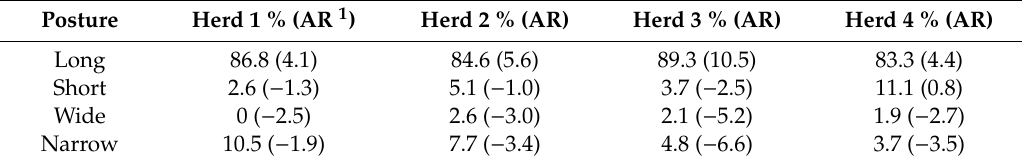
Figure 4. Percentage of “long”, “wide”, “short”, and “narrow” postures per herd, as recorded in 357 observations of 205 cows in four herds on one farm in Uruguay, lying outdoors on pasture. Table 2. Percentage of “long”, “wide”, “short”, and “narrow” lying postures for cows on pasture in Uruguay, within and between four herds on one farm. Herd 1 are pregnant, non-lactating cows, while herds 2, 3, and 4 are non-pregnant and lactating. Results of a chi-square analysis with adjusted residuals (AR).